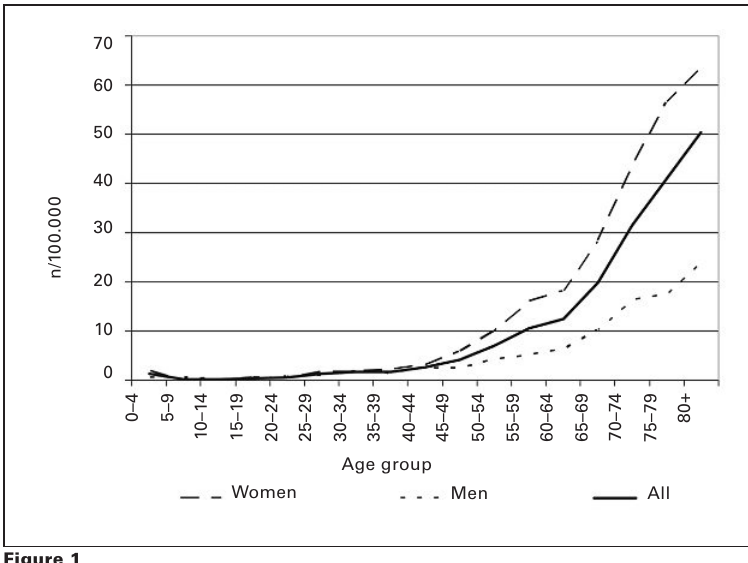
2000–2004.70 In-hospital prevalence of primary hyperparathyroidism in Switzerland, 2000–2004.